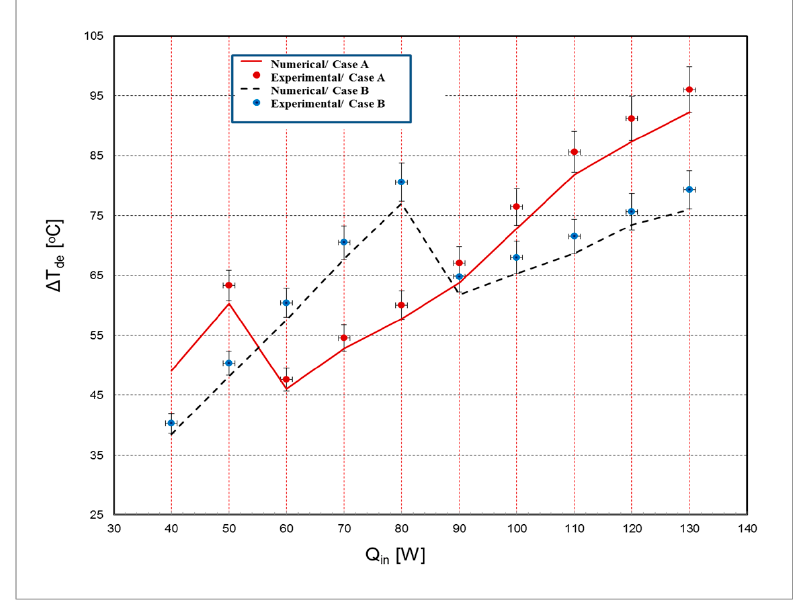
Figure 11. Temperature difference between hot and cold side of TEG modules ( Δ Tde) .